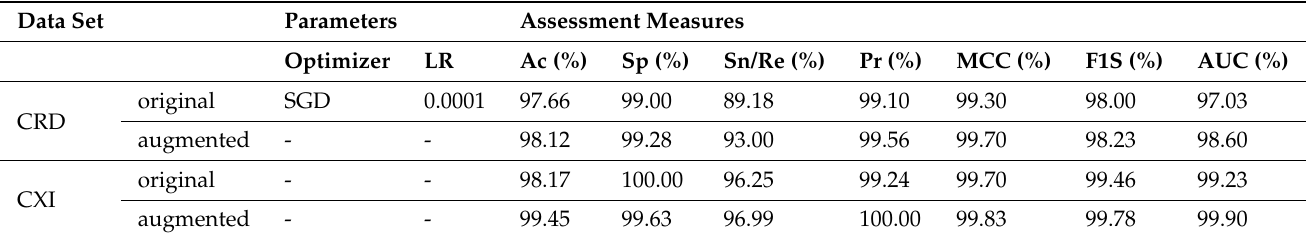
Table 5. R2DCNNMC model performance evaluation on original and augmented CRD and CXI data sets. Data Set